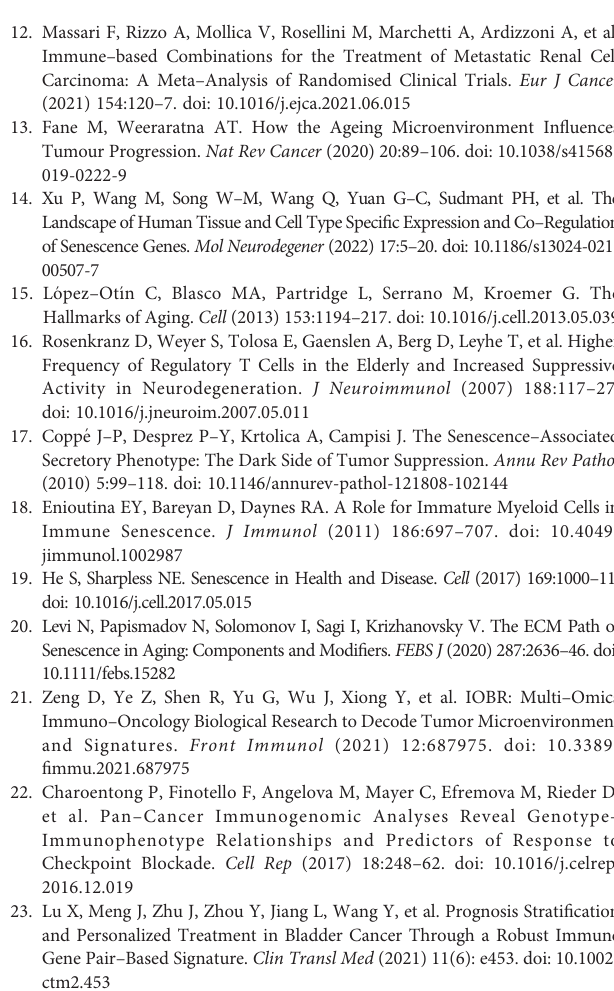
Supplementary Figure 1 | Regeneration of the senescence subtypes in external cohorts. (A) Heatmap displayed the expression level of the DESGs across the senescence subtypes in TCGA-KIRC. (B, D, F) the t-SNE down-dimension plots showed good discrimination of tumor samples among the senescence subtypes in TCGA-KIRC (B) ,E-MTAB-1980 (D) ,andCheckmate (F) . (C,E) Heatmapsofthe15 senescence-related biological processes in E-MTAB-1980 (C) and Checkmate (E) . Supplementary Figure 2 | Subgroup analysis of ICB treatment bene fi t versus targeted therapy in Checkmate. (A, B) In patients of the low-senescence score group, the use of Nivolumab resulted in an OS, but not a PFS bene fi t over Everolimus. (C, D) In the high-senescence score group, there was no PFS or OS difference between the Nivolumab- and Everolimus-treatment arms. Supplementary Table 1 | Information of datasets involved in our study. Supplementary Table 2 | Clinic information for the development and validation datasets of the prognostic model. Supplementary Table 3 | Differentially expressed senescence-related genes in TCGA-KIRC (p < 0.05). Supplementary Table 4 | Features and corresponding coef fi cients for the generation of the senescence